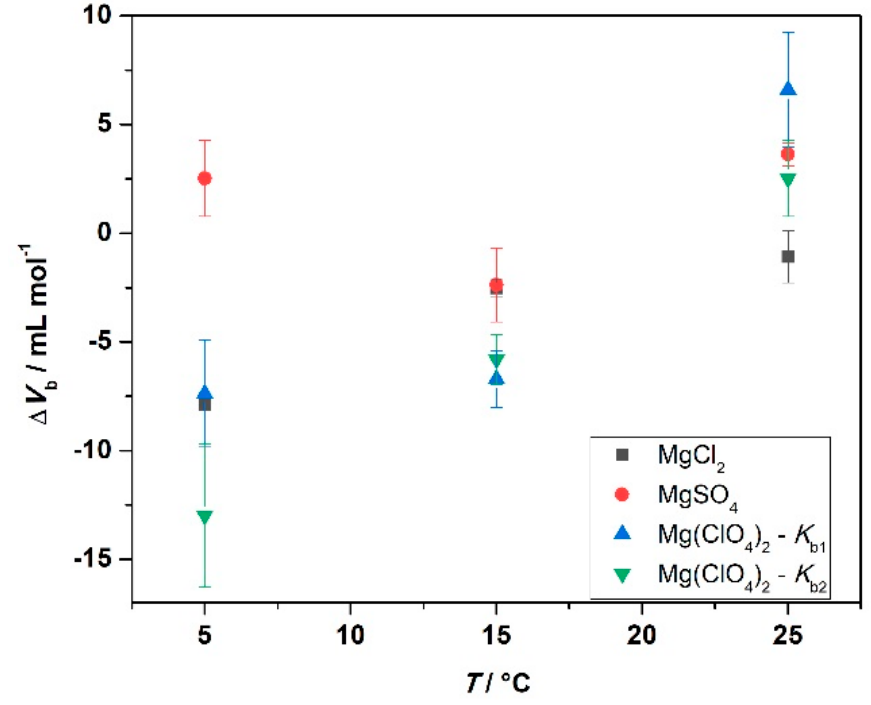
Figure 6. Plot of binding volumes, Δ V b , as a function of temperature for the indicated 250 mM salt solutions.